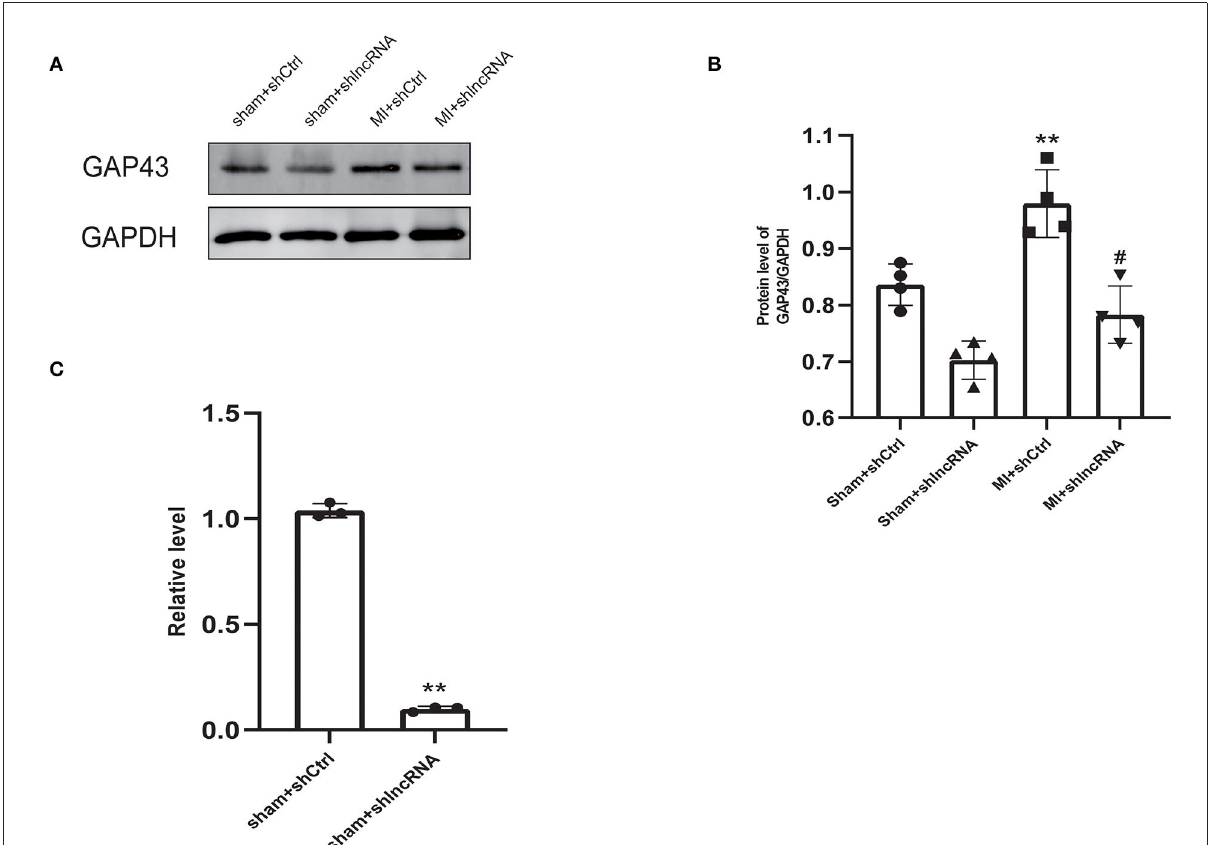
FIGURE5 LncRNA LOC100911717 silencing inhibits GAP43 expression after MI. (A) Representative picture of the protein bands of MI myocardium from the four groups, sham + shCtrl, sham + shlncRNA, MI + shCtrl, and MI + shlncRNA; n = 4 per group. (B) Normalized GAP43 compared with GAPDH. **A P- value of < 0.01 compared with the sham + shCtrl group and # A P- value of < 0.05 compared with the MI + shCtrl group. (C) Comparison of GAP43 mRNA expression between the sham + shCtrl and sham + shlncRNA groups. n = 3 per group. ** P < 0.01 compared with the sham